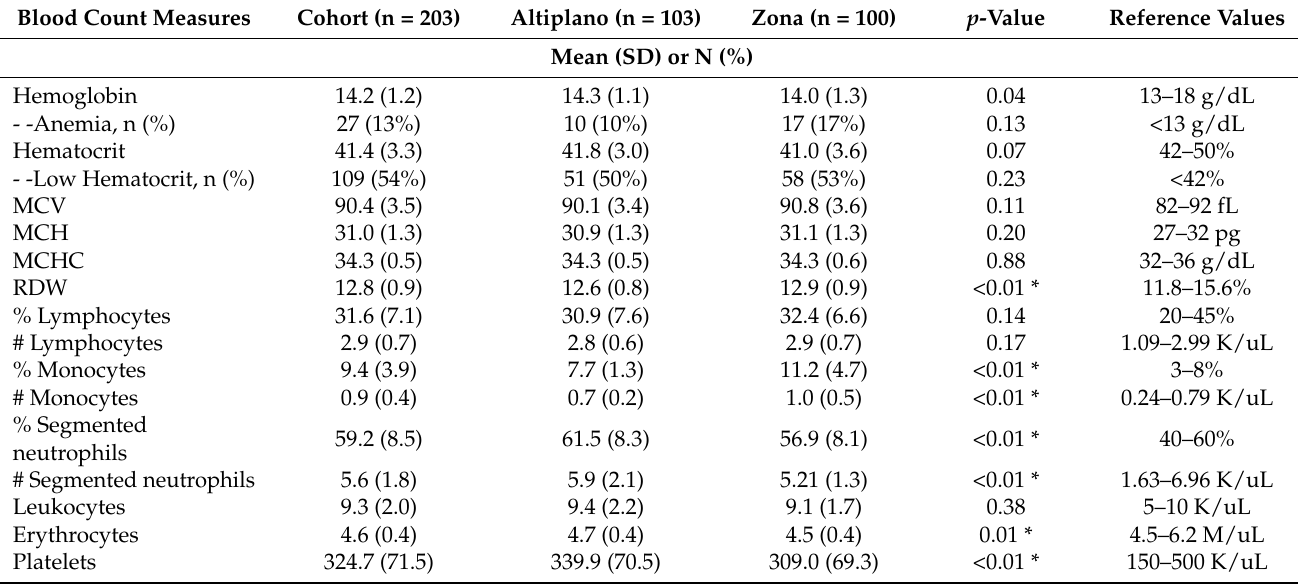
Table 3. Complete blood count (CBC)